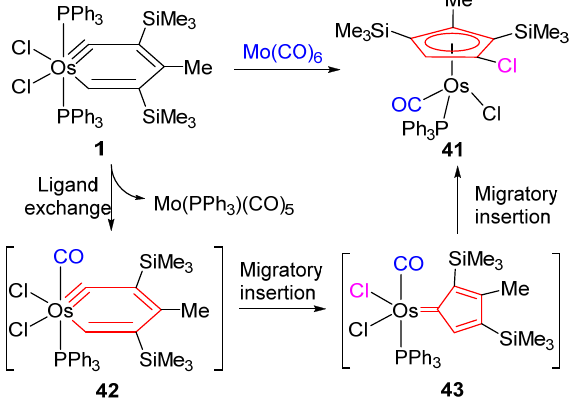
Scheme 9. Ligand effect on migratory insertion reaction.